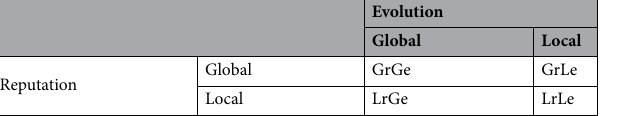
Table 3. General overview of model variants. G and L represent Global and Local, r and e represent Reputation and